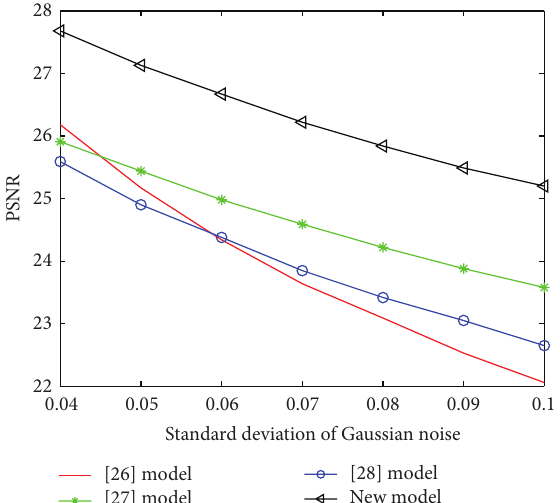
Figure 8: PSNR (dB) graph of [26–28] and new algorithms for various Gaussian noises for Salesman video sequence.